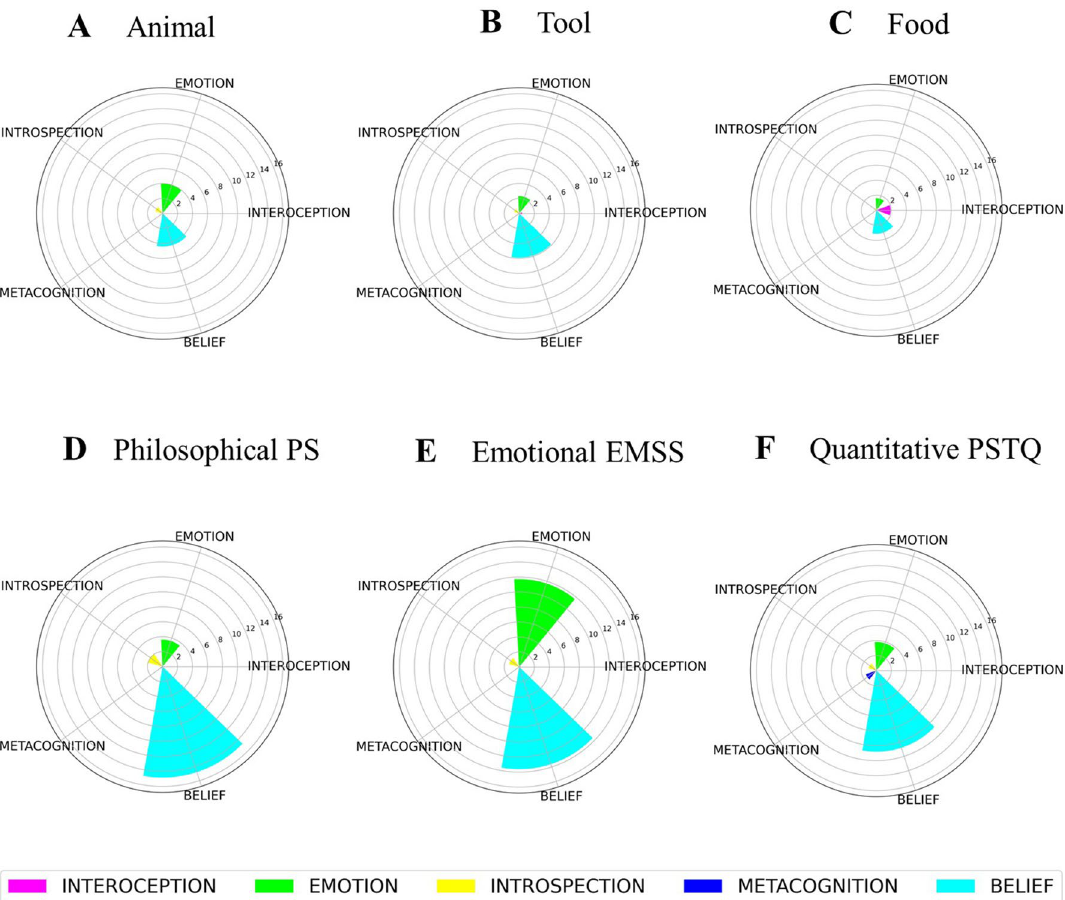
Figure 3. Polar plots for sentences including animals ( A ), tools ( B ), food ( C ), PS, philosophical-spiritual ( D ), EMSS, emotional-social ( E ), and PSTQ, physical-spatio-temporal-quantitative ( F ) concepts, showing the percentage of inner grounding dimensions, i.e., emotion (lime), interoception (fuchsia), belief (cyan), metacognition (blue), introspection compared to animals sentences (− 0.3%; 95% CI [− 1.2, 0.1]; PP = 6.2%); strong evidence that Auditory features were more frequent with animal and tool sentences than food sentences (0.5%; 95% CI [0.1, 1.2]; PP = 100%), and strong evidence for the hypothesis that, within CCs, Material features were more frequent with food and tools sentences compared to food sentences (4.2%; 95% CI [2.8, 5.7]; PP = 100%). Within ACs, contrast analysis showed strong evidence for the hypothesis that the more concrete PSTQ sentences elicited more Visual features than other ACs (i.e., EMSS, PS) (0.6%; 95% CI [− 0.1, 1.4]; PP = 95.4%). Thematic relations: space, time, events, and actions. Spatial features were more frequent with CCs than ACs. In addition, contrast analysis showed strong evidence for the hypothesis that Spatial features were more frequent with tool sentences than other CCs (4.9%; 95% CI [3.1, 7]; PP = 100%). Within ACs, we found inconclusive evidence that Spatial features were more frequent with the most concrete PSTQ sentences com- pared to the other ACs (i.e., EMSS, PS) (− 0.02%; 95% CI [− 0.5, 0.6]; PP = 47.3%). We found inconclusive evidence for the hypothesis that ACs elicit more Temporal features than CCs. However, contrast analysis showed strong evidence for the hypothesis that, within ACs, the most concrete PSTQ sentences evoke more Temporal features than other ACs (1.3%; 95% CI [− 0.2, 2.9]; PP = 95.9%). Within CCs, we found inconclusive evidence for the hypothesis that animal sentences evoke more Temporal features compared to other Events were more frequent with ACs than CCs. Concrete actions were more frequent with CCs than ACs. Within CCs, contrast analysis showed strong evi- dence that Concrete Actions were more frequent with food and tools sentences than animal sentences (4.3%; 95% CI [0.3, 8.1]; PP = 98.3%). Within ACs, contrast analysis showed strong evidence for the hypothesis that PSTQ sentences elicit more Concrete Actions than other ACs (i.e., EMSS, PS) (5.3%; 95% CI [3.4, 7.6]; PP = 100%). Abstract Actions were more frequent with ACs than CCs. In addition, contrast analysis showed inconclusive evidence in support of the hypothesis that Abstract Actions were more frequent with PSTQ sentences than PS and EMSS sentences (− 2.1%; 95% CI [− 4.21, 0]; PP = 2.4%), and actually, it was more plausible that the effect